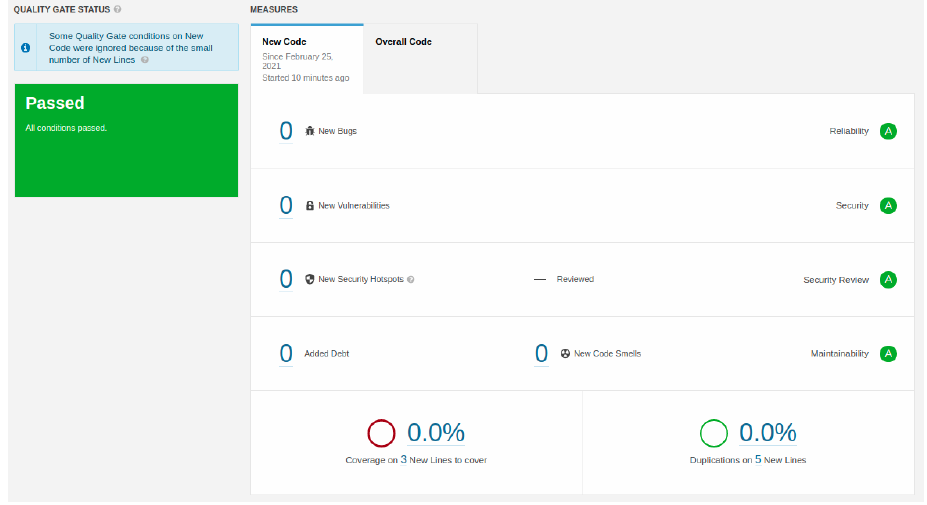
Figure 9. Results of static tests in the proposed